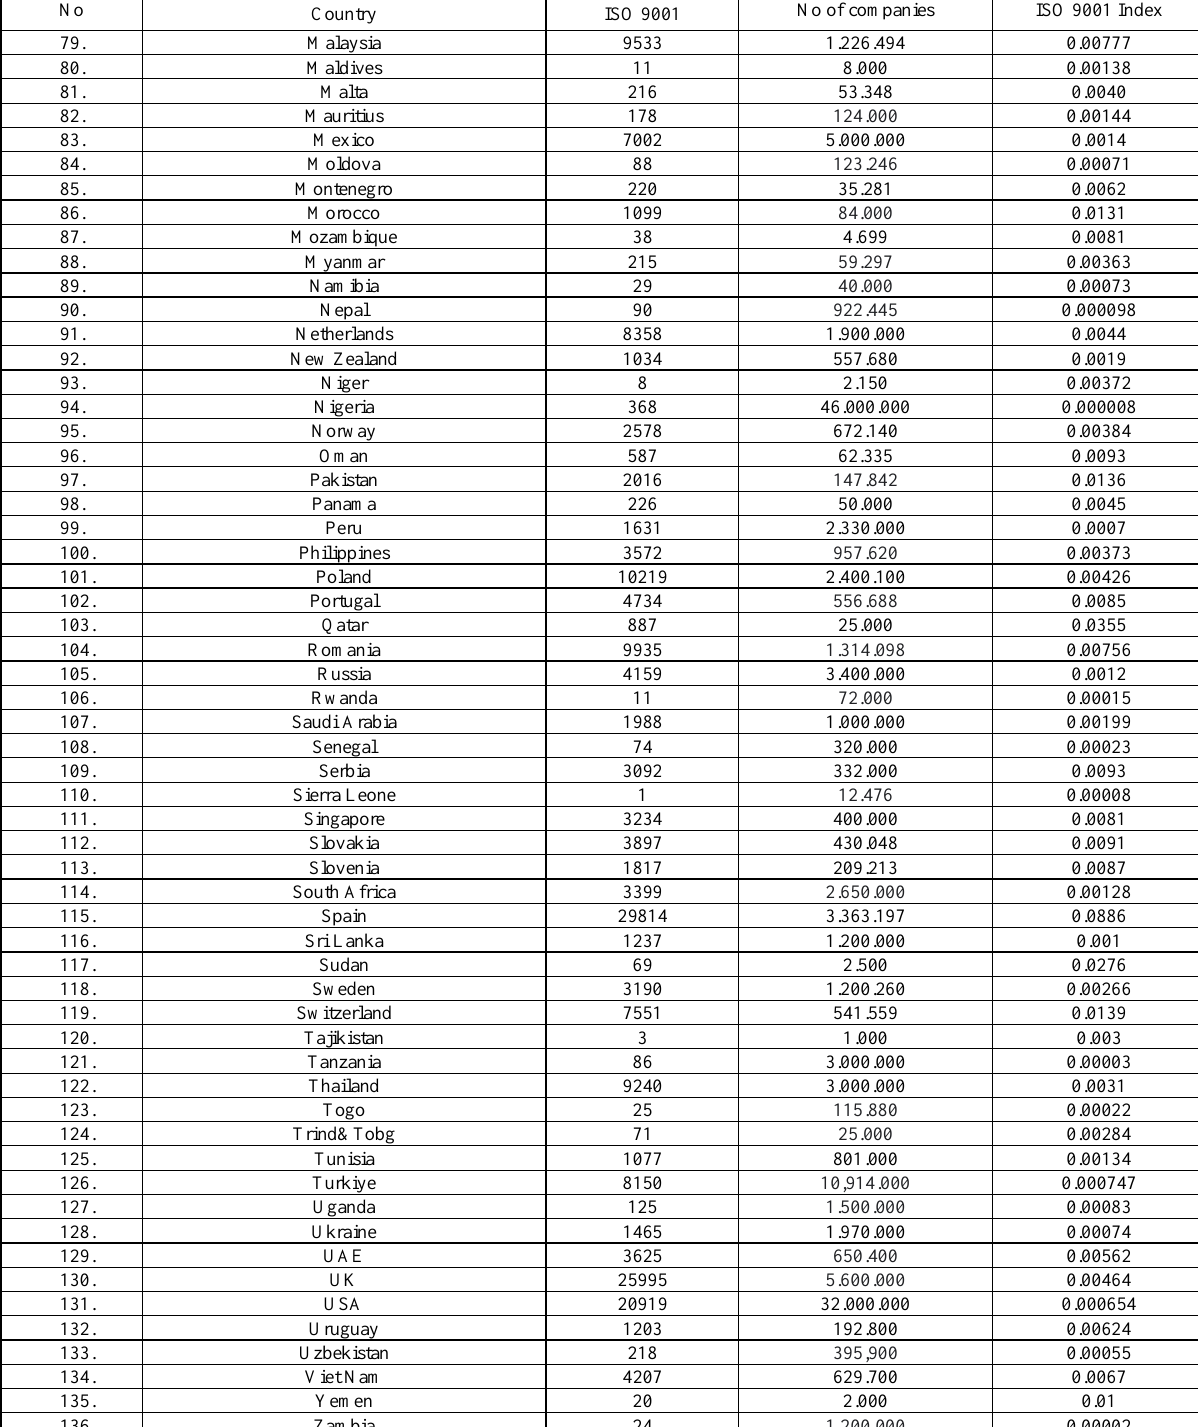
Table 1 (cont.). List of countries for ISO 9001 certificates issued in alphabetic order (taken from ISO), number of businesses per country (taken from HitHorizon), and ISO 9001 index per country (136 countries